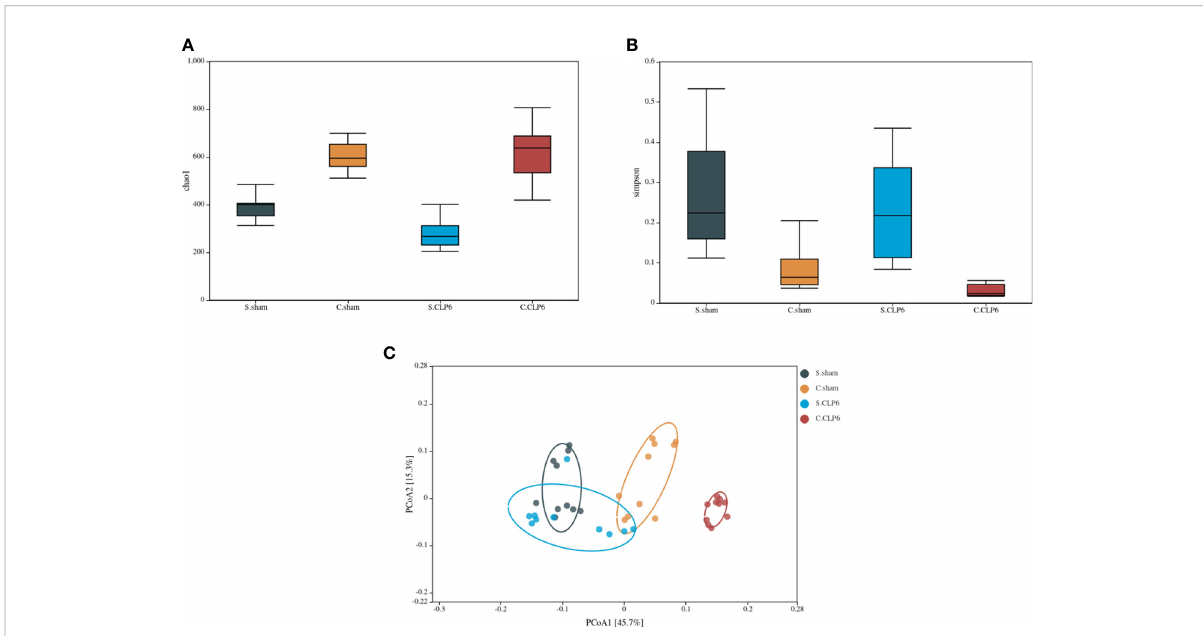
FIGURE 4 Changes in the composition of the microbiota in different intestinal segments. (A) Comparison of gut microbiota richness in the small intestine and colon before and after sepsis. (B) Comparison of gut microbiota diversity of the colon and small intestine before and after sepsis. (C) PCoA analysis. The dots with different colors represent different sample groups. The closer the spatial distance of the sample is, the more similar the species composition structure of the sample